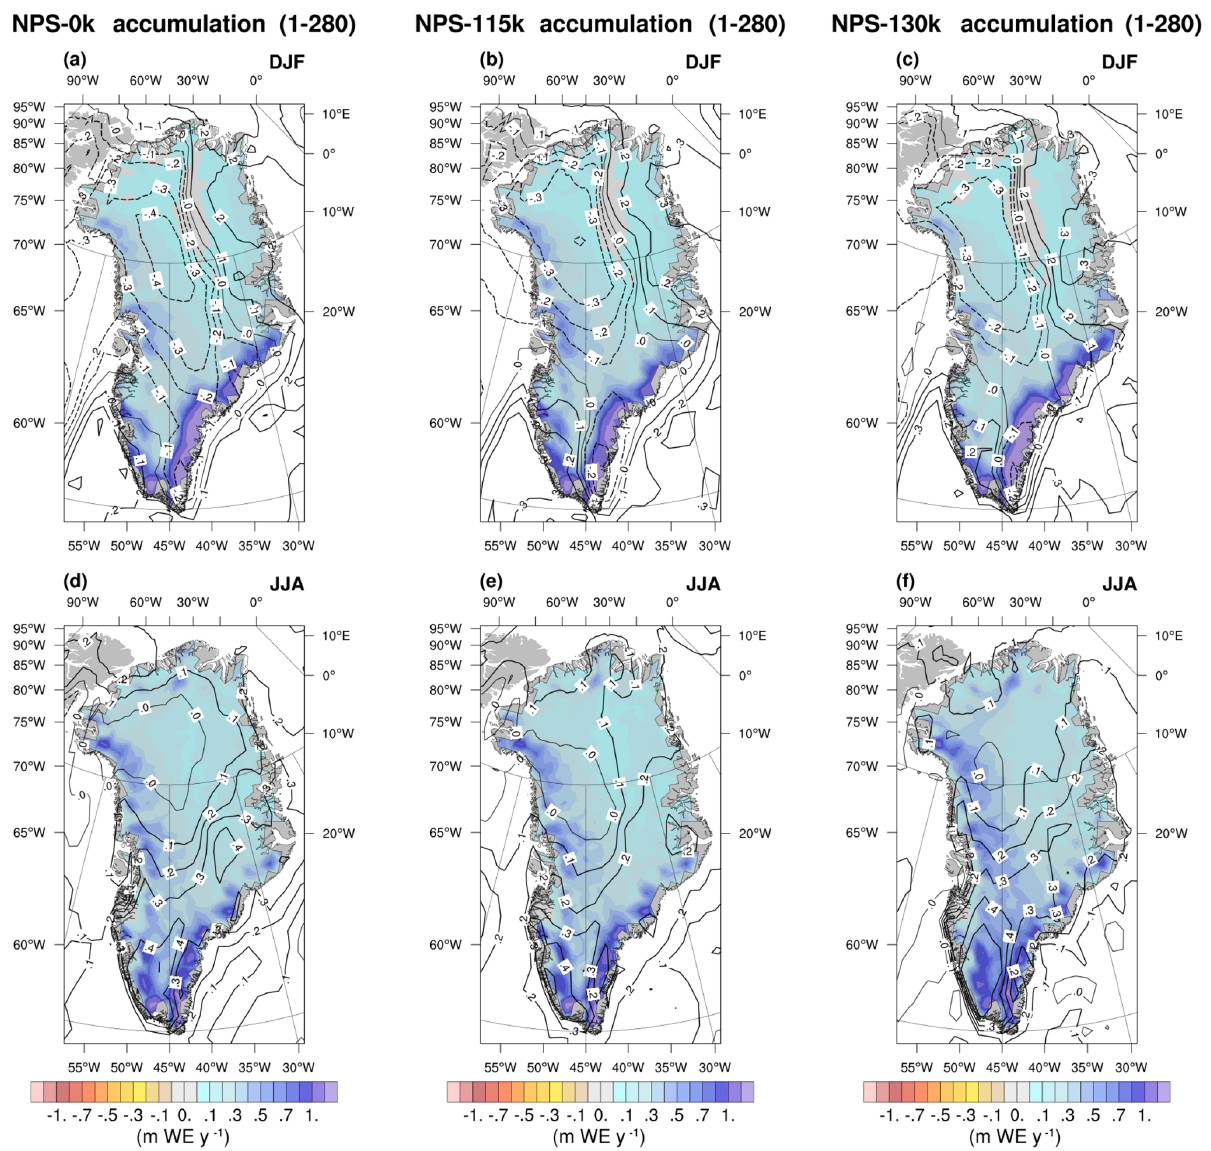
Figure 9. Mean accumulation (in mWEyr − 1 ) and (superimposed) its correlation with the NAO index for (a, d) the preindustrial period, (b, e) 130ka and (c, f) 115ka in (a, b, c) winter and (d, e, f)